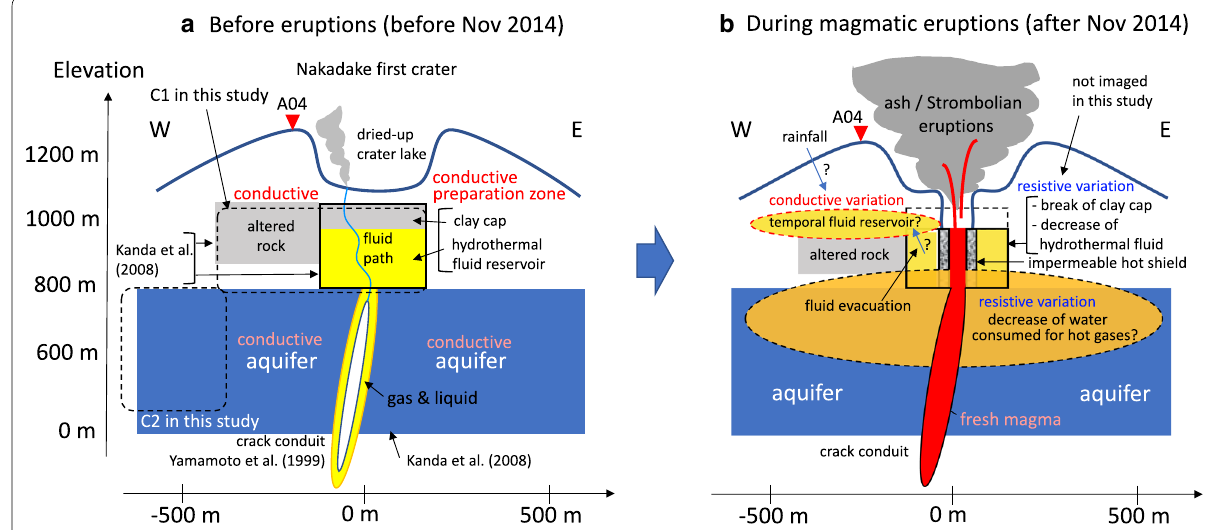
Fig. 5 Conceptual model of the subsurface structure before and after magmatic eruptions began on November 25,